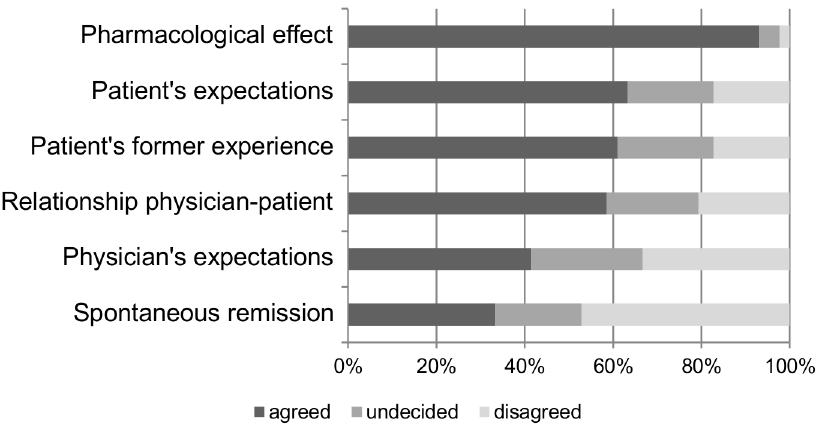
Fig 1. Physicians’ agreement to different explanatory models for antidepressant effectiveness. Depictedis the percentageof participantswho agreed, disagreed or were undecided whether they agreedto the suggested mechanismsof effectiveness for